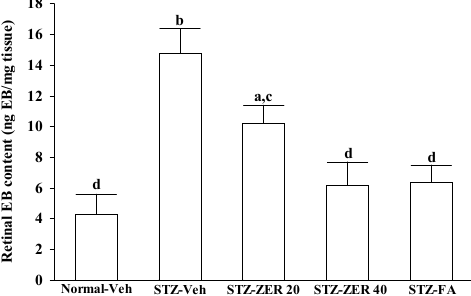
Figure 3. Effects on retinal vascular permeability. STZ-diabetic rats were administered 20 mg/kg/day zerumbone (STZ-ZER 20), 40 mg/kg/day zerumbone (STZ-ZER 40) or 100 mg/kg fenofibric acid (STZ-FA) by oral gavage once daily for three months. Another group of STZ-diabetic rats (STZ-Veh) and normal rats (Normal-Veh) were administered the same volume of vehicle used to prepare the test medication solutions. Retinal vascular permeability was measured with EB dye as a tracer. EB was normalized by total protein concentration in the tissue. Permeability is expressed as ng of dye per mg of protein in the tissue. Data are mean ± SD from eight rats per group, and the experiments were